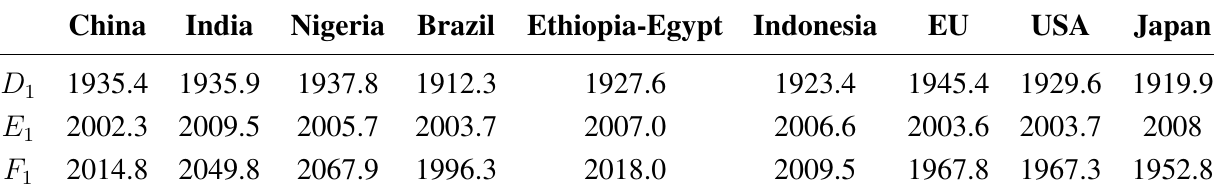
Table 4. Starting dates for exponential functions.